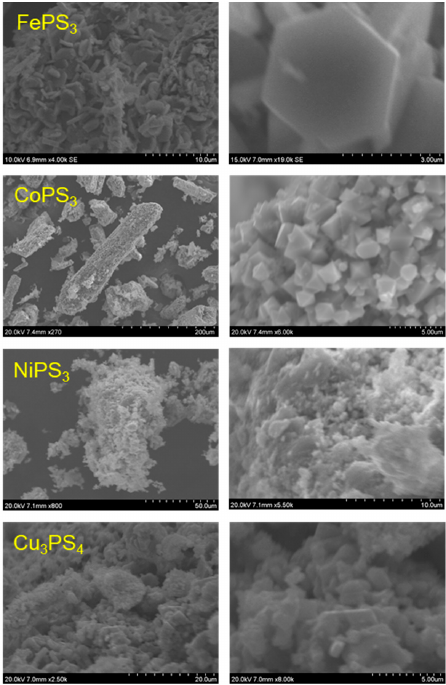
Figure 4. SEM images of M-P-S materials synthesized from metal halides and (P + S) at 500 ◦ C. The right images are higher magnification images of the products shown in the left